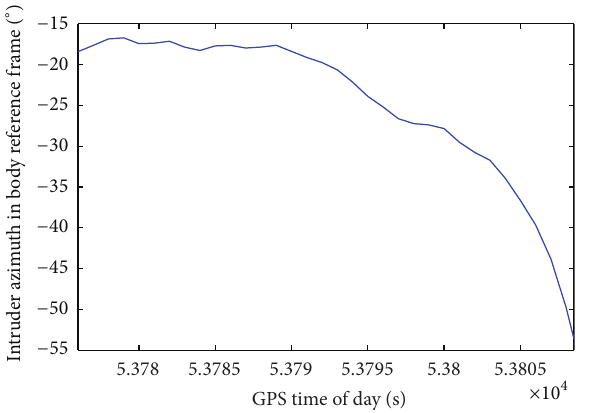
Figure 11: Intruder azimuth in body reference frame in the consid- ered scenario as estimated by GPS, as a function of GPS time of day.